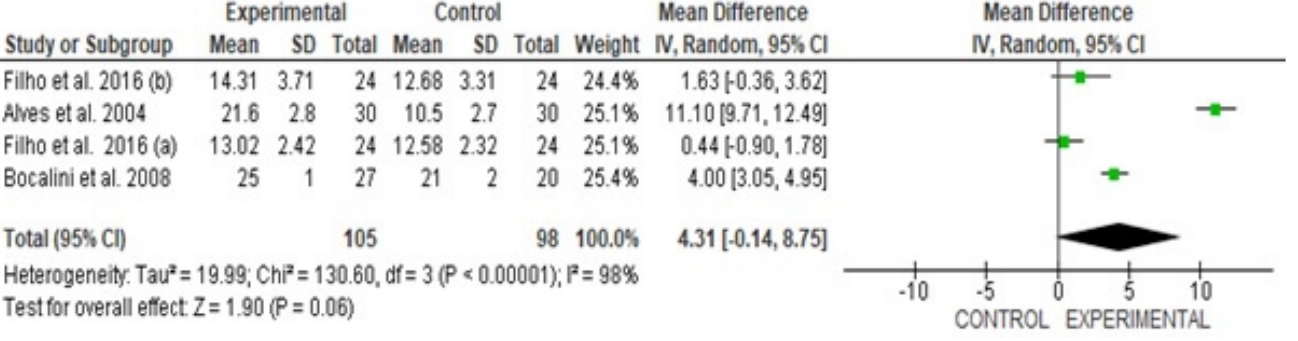
Figure 3. Forest plot of the four results of the three studies selected for brachial biceps strength and endurance measured by the Arm Flexion (repetitions) test in the Rikli Jones test battery.